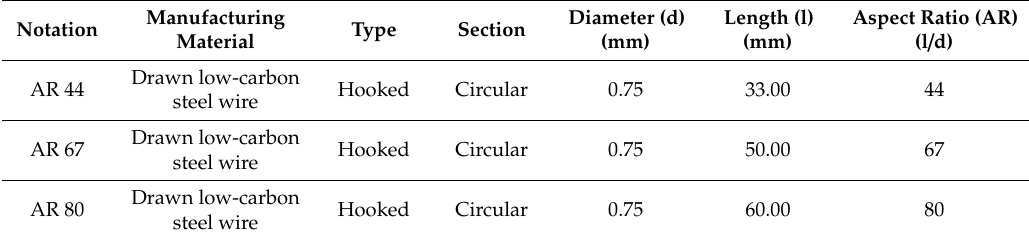
Table 2. Properties of the steel fibers used in this